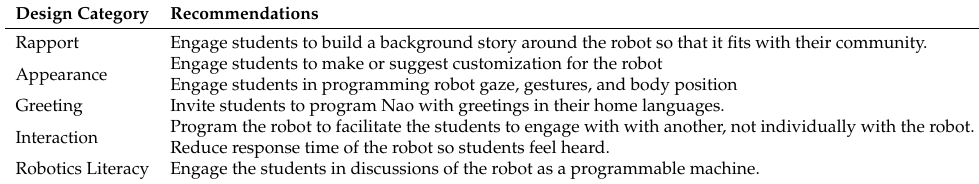
Table 2. Summary of